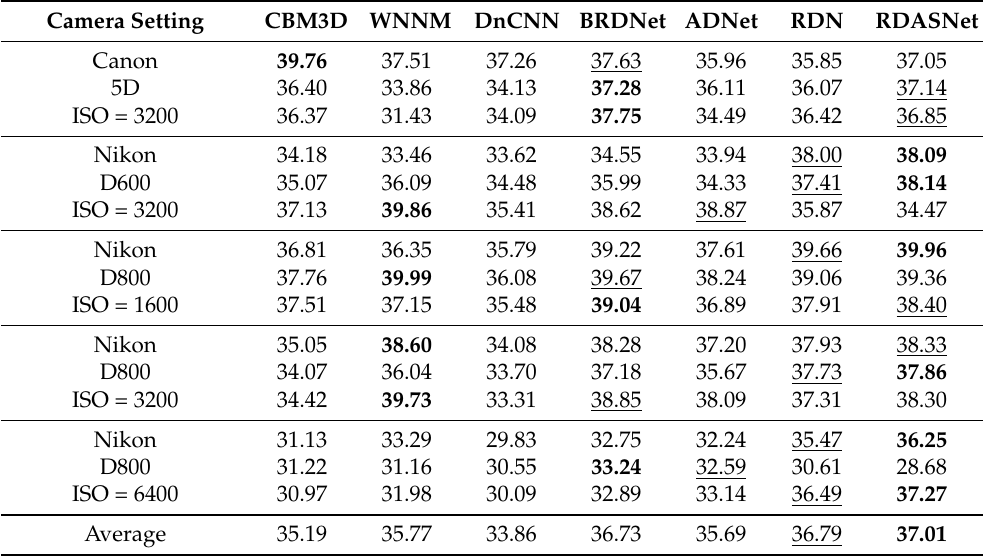
Table 5. PSNR (dB) of different methods using the cc dataset. The best two results are shown in bold and underlined,